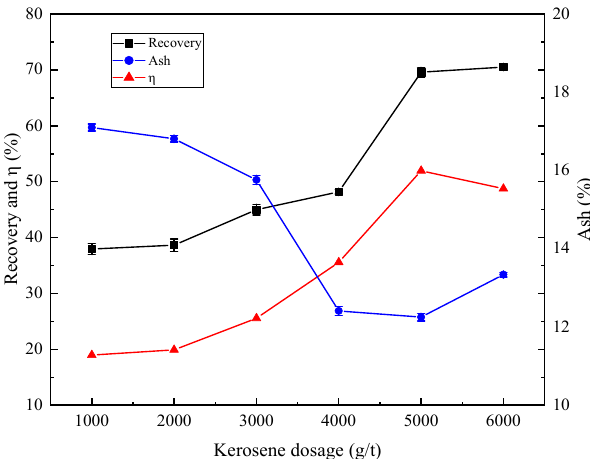
ff ect of kerosene dosage on flotation Figure 2. Effect of kerosene dosage on flotation indices. Figure 2. E